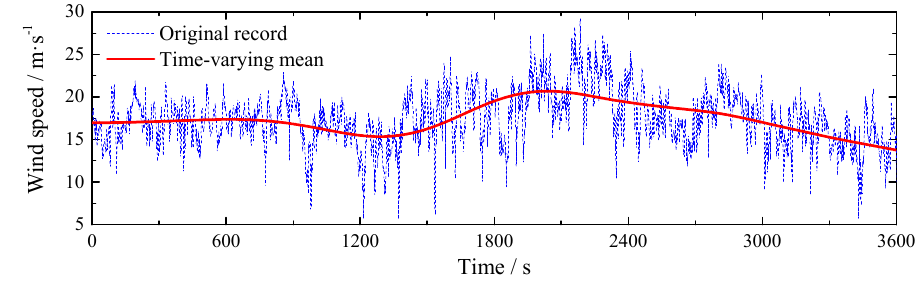
Figure 10. Wind record for power spectral density analysis.